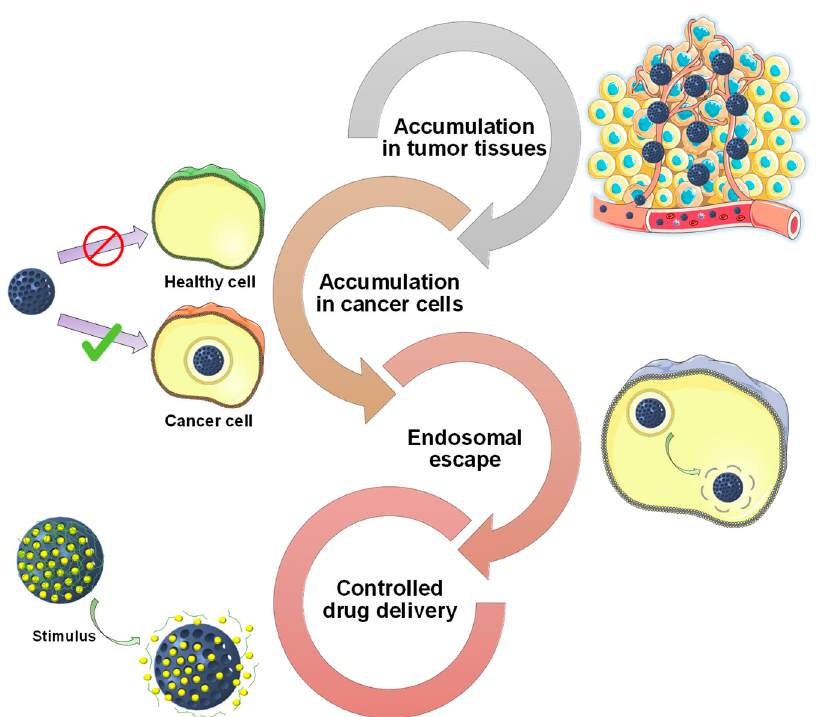
Figure 1. Schematic representation of relevant barriers that mesoporous silica nanoparticles (MSNs) have to face when administered to a patient. These barriers include potential premature release and different biological barriers, such as lack of accumulation in tumor tissues, lack of accumulation in cancer cells and sequestration in the endo-lysosomes.